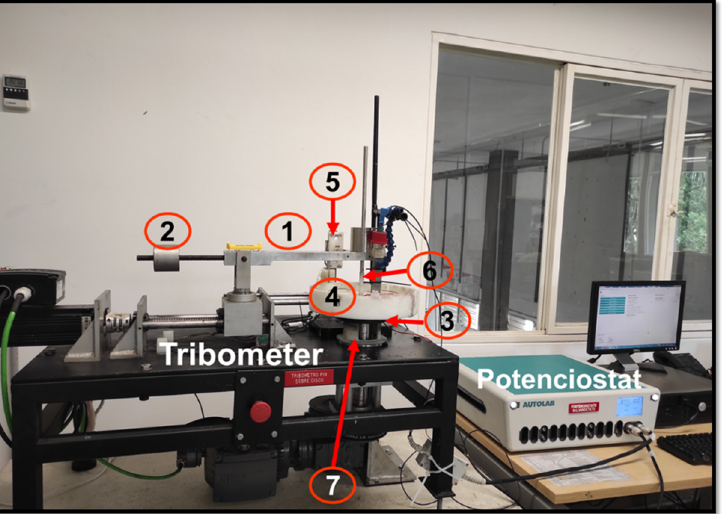
Figure 1. Final setup of the device. 1. Level arm; 2. Counterweight; 3. Disc; 4. Corrosion cell; 5. Load cell holder; 6. Counterbody holder and 7. Electrical adaptation.